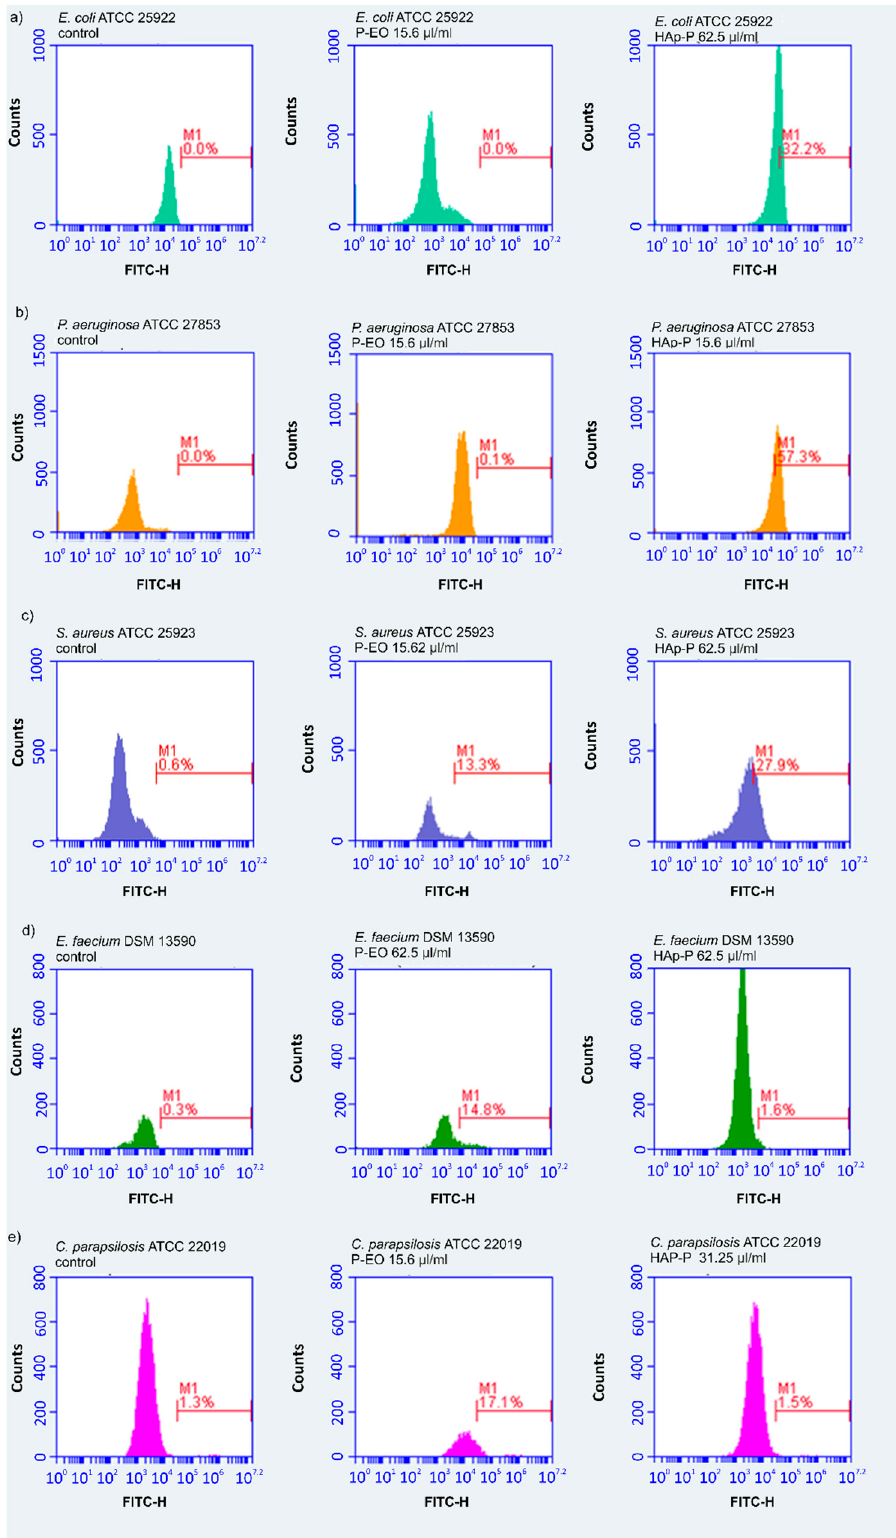
Figure 4. DiBAC4(3) staining (log fluorescence) of ( a ) Escherichia coli ATCC 25922, ( b ) Pseudomonas aeruginosa ATCC 27853, ( c ) Staphylococcus aureus ATCC 25923, ( d ) Enterococcus faecium DSM 13590 and ( e ) Candida parapsilosis ATCC 22019. Part of the fluorescent depolarized bacteria with increased green fluorescence caused by an accumulation of the dye inside the microbial cell, expressed in percentages.